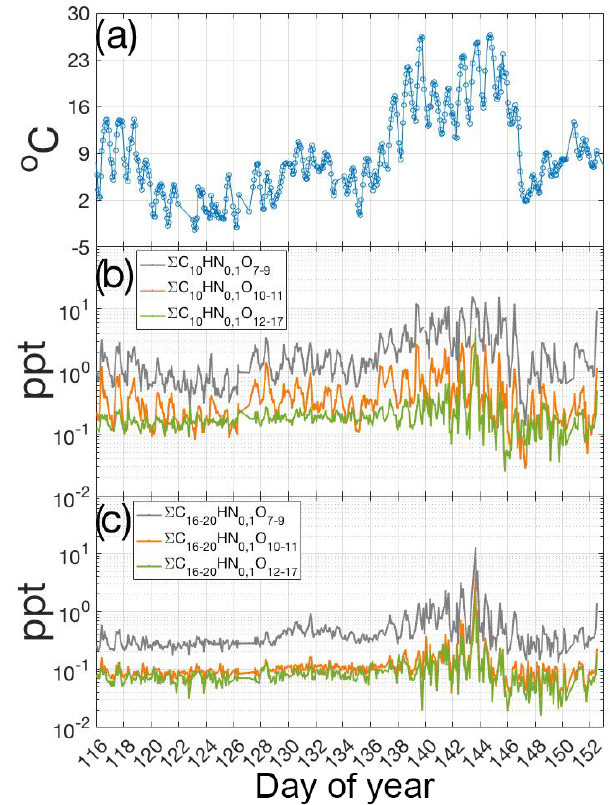
Figure 2. (a) Ambient temperature, (b) sum of the mixing ratios of three groups of gas-phase HOM monomers with varying ranges of oxygen atom number, and (c) sum of the mixing ratios of three groups of gas-phase HOM dimers with varying ranges of oxygen atom number, all observed during the BAECC campaign in the year 2014. Measurements of (b) and (c) were made with the FIGAERO- CIMS utilizing iodide-adduct